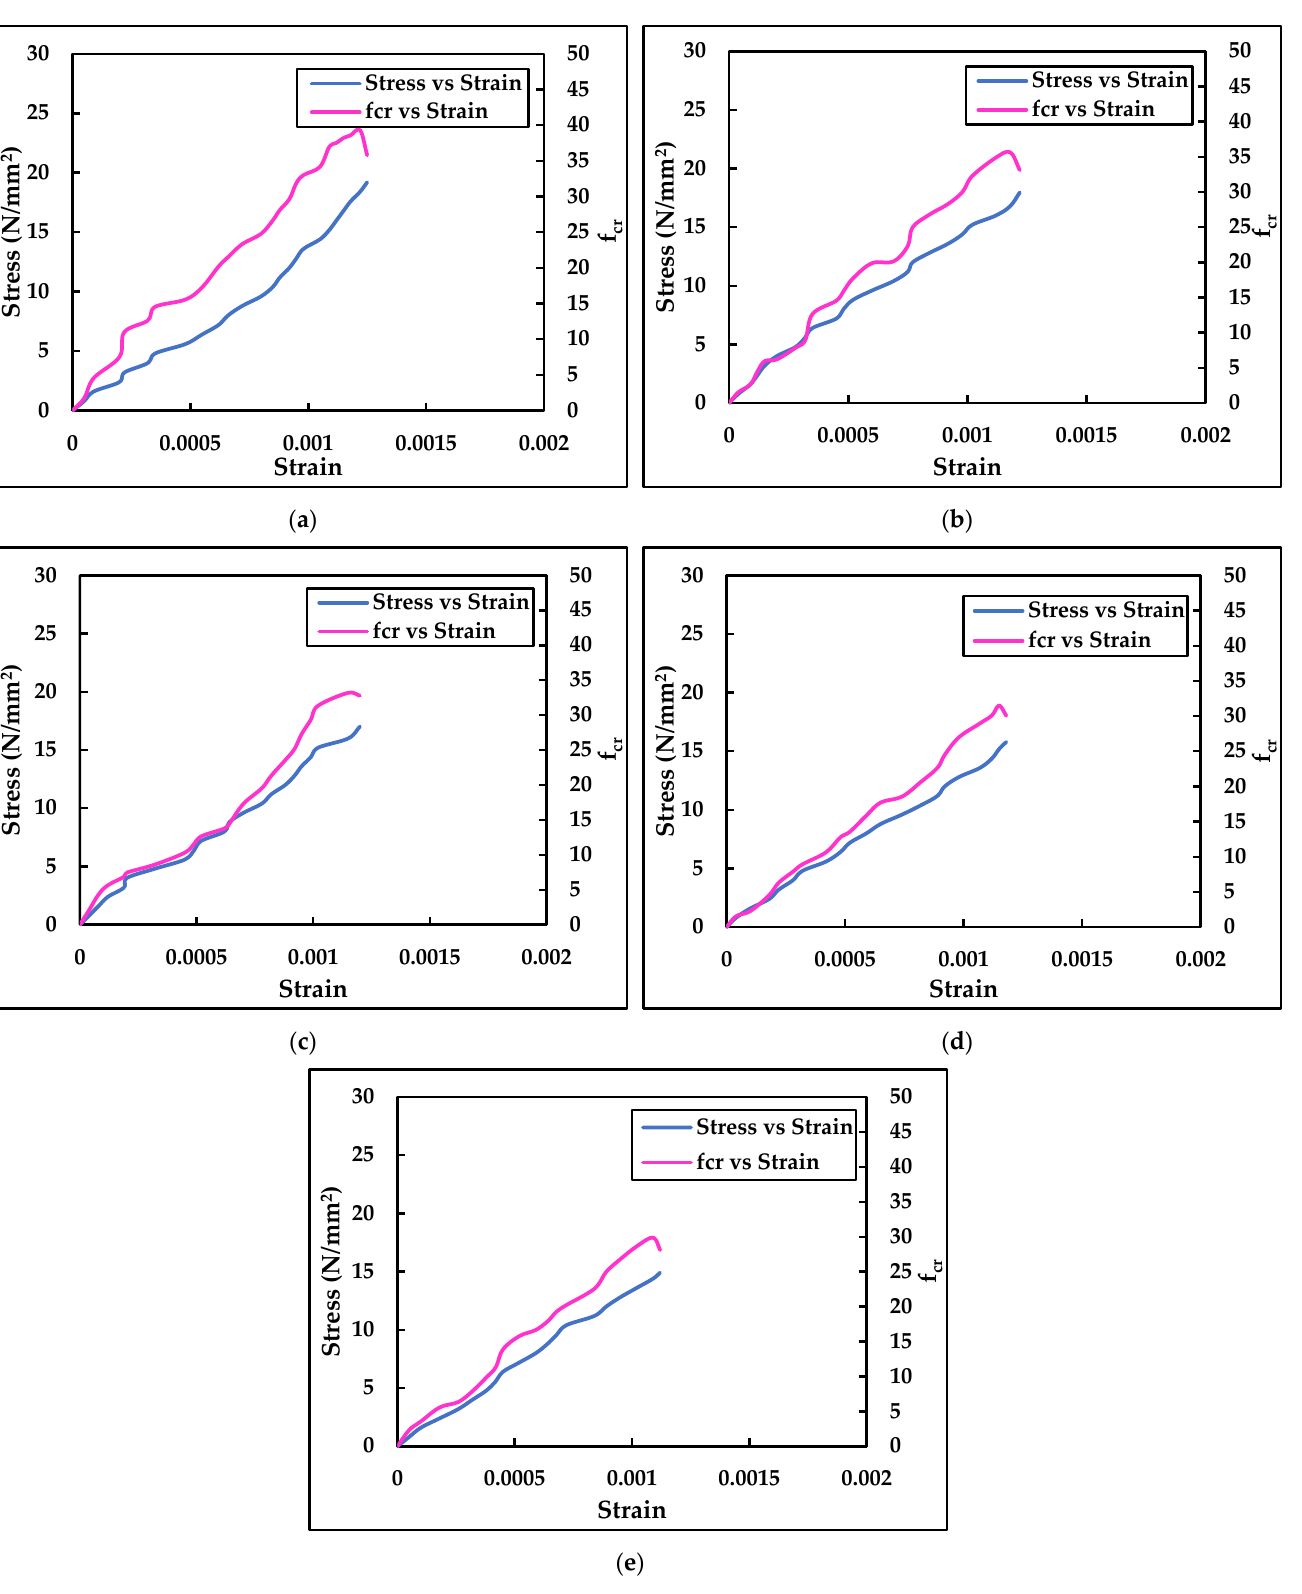
Figure 17. Graphical illustration of stress vs. strain and f cr vs. strain for hybrid brass carbon fibre added mortar cube after 28 days of water curing subjected to elevated temperatures. ( a ) Room temperature; ( b ) 200 °C; ( c ) 400 °C; ( d ) 600 °C; ( e ) 800 °C.